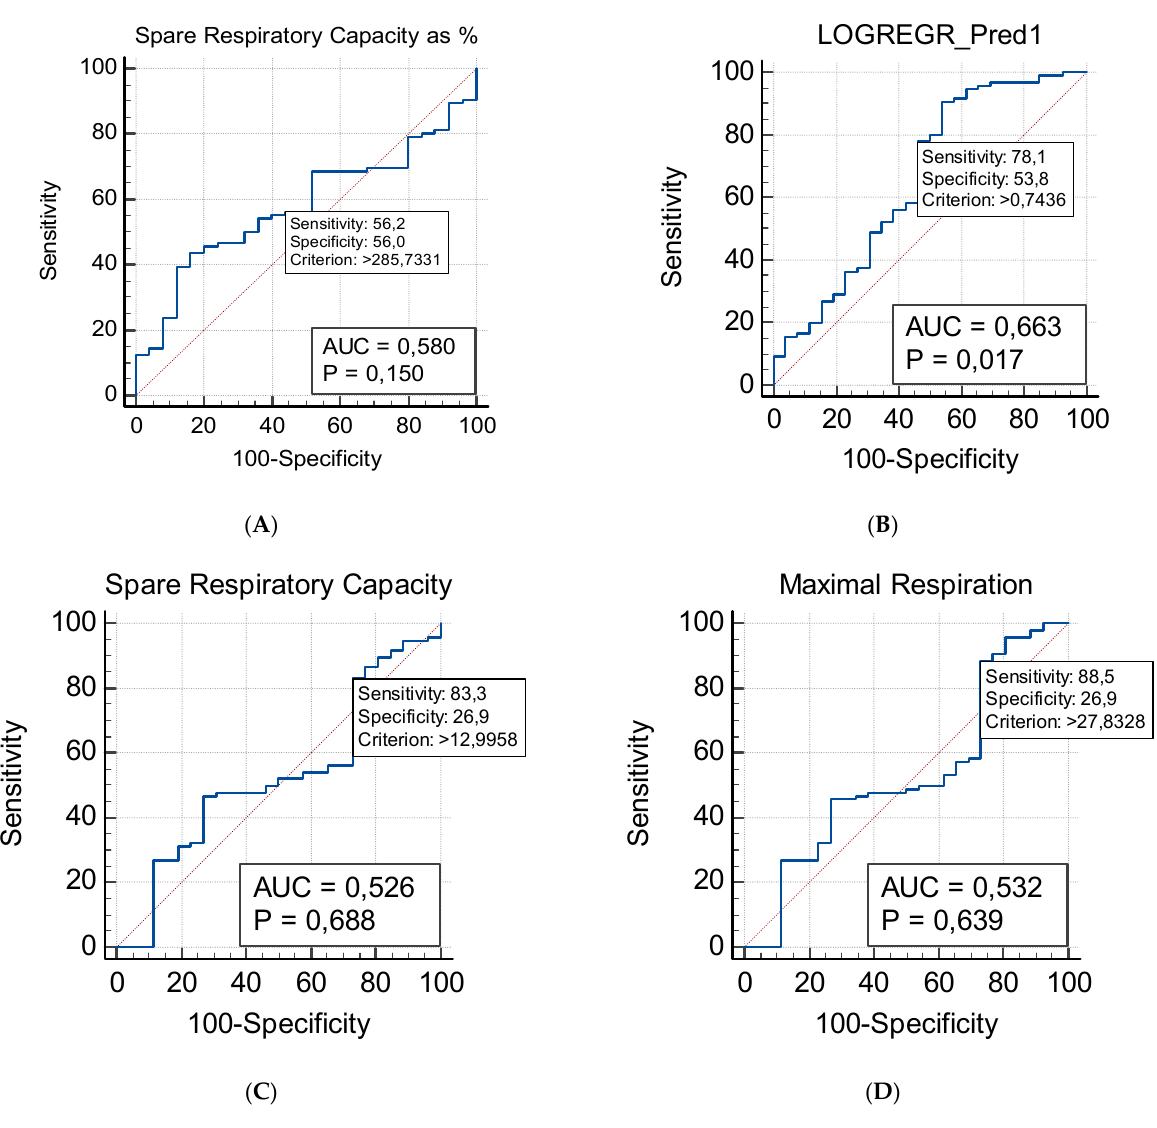
Figure 5. ROC (Receiver Operating Characteristic) analysis of mitochondrial respiration parameters in patients with ASD ( n = 40) ( A ) Spare Respiratory Capacity as %; ( B ) Additive model that involve the Maximal Respiration and the Spare Respiratory Capacity; ( C ) Spare Respiratory Capacity as absolute values; ( D ) Maximal